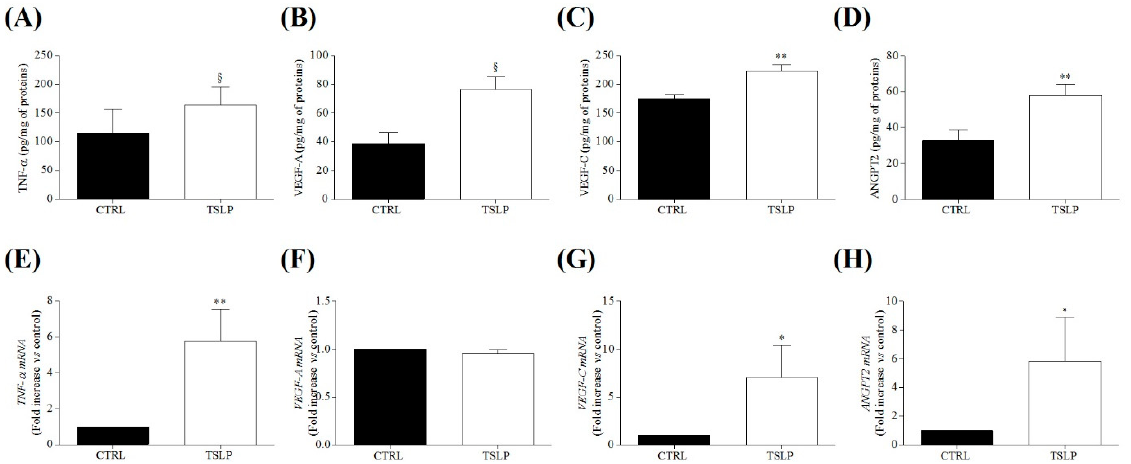
Figure 6. Effects of TSLP on the release and expression of inflammatory, angiogenic and lymphangiogenic mediators from HLMs. HLMs (1.5 × 10 5 cells/well) were incubated (16 h, 37 ◦ C) in the absence (CTRL) or in the presence of TSLP (5 ng/mL). At the end of the incubation, TNF- α ( A ), VEGF-A ( B ), VEGF-C ( C ) and ANGPT2 ( D ), and concentrations in the supernatants were evaluated by ELISA. In parallel experiments, HLMs (4.5 × 10 5 cells/well) were incubated (6 h, 37 ◦ C) in the absence (CTRL) or in the presence of TSLP (5 ng/mL). TNF- α ( E ), VEGF-A ( F ), VEGF-C ( G ), and ANGPT2 ( H ) mRNAs were determined by quantitative RT-PRC. Data are mean ± SD of 4 independent experiments obtained from different patients. § p < 0.0001 vs. control (CTRL). * p < 0.05 vs. control; ** p < 0.01 vs. control (CTRL).